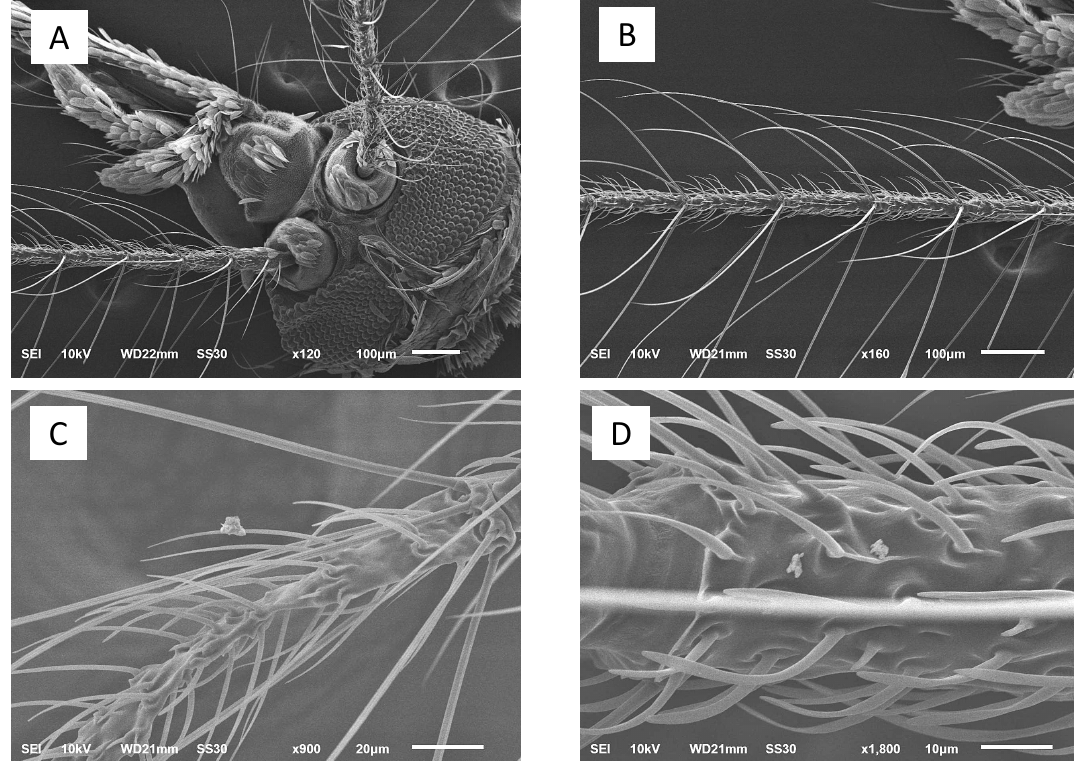
Figure 5. Fine morphology of the antenna of mosquitoes with and without PM 2.5 exposure: ( A , B ) a negative control mosquito showing no particles on the antenna; ( C , D ) a PM 2.5 -exposed mosquito showing particles on the antenna.